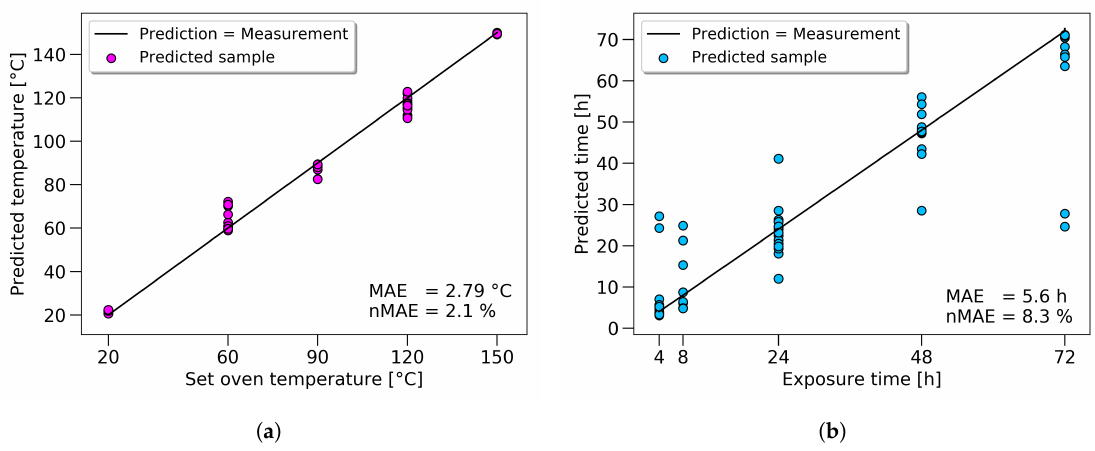
Figure 11. Overview of the results for the most precise ANN predictions regarding temperature ( a ) and time ( b